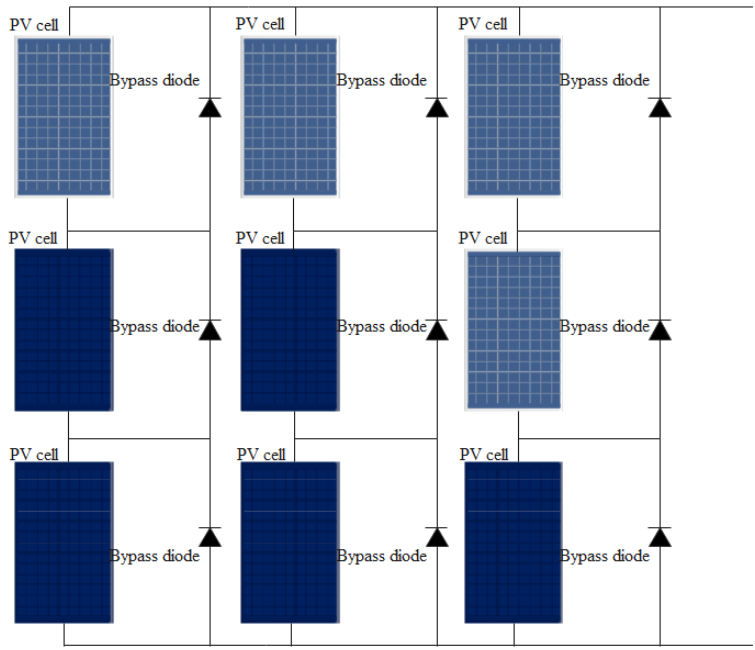
Figure 1. Schematic diagram of the presence of shadows during photovoltaic power generation. The output characteristic curve of the PV power system under uniform light conditions is demonstrated in Figure 2. Figure 3 illustrates the PV power output characteristic curve under shading conditions.